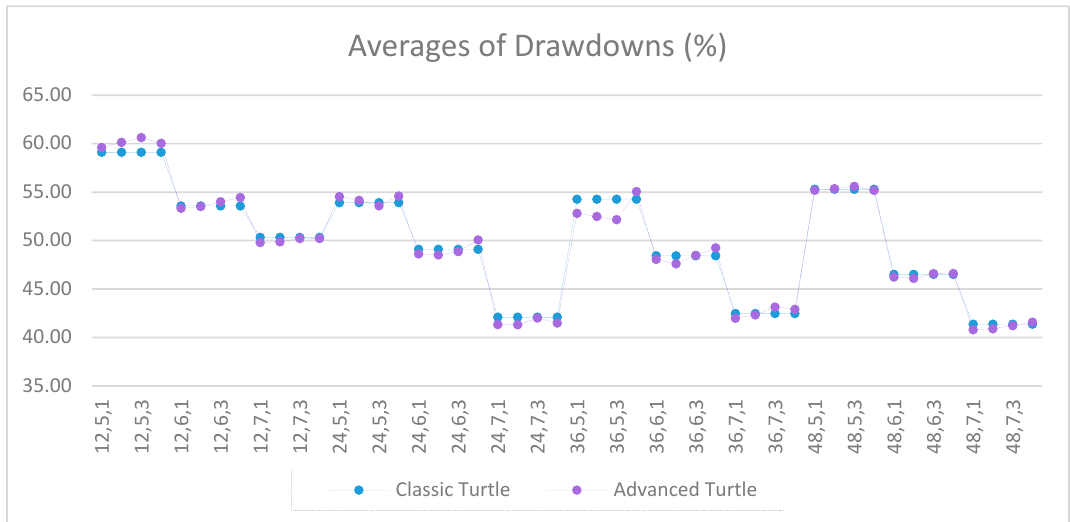
Figure 15. Averages of profits between the classic and the advanced Turtle systems for every combination of N, X, Y for the slow parameters (80, 160), where X ≥ 5.